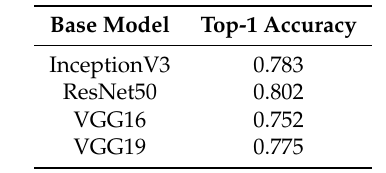
Table 4. Performance of base image classifiers for the single-input model.